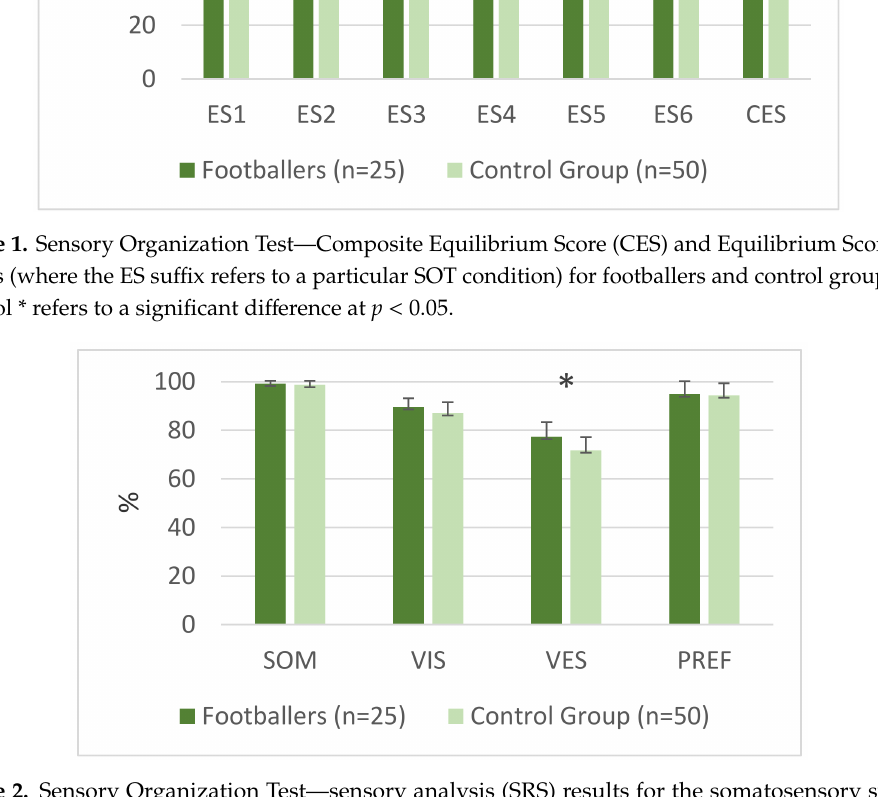
Figure 2. Sensory Organization Test—sensory analysis (SRS) results for the somatosensory system (SOM), the visual system (VIS), the vestibular system (VES), and visual preference (PREF) for footballers and control group. The symbol * refers to a significant di ff erence at p <